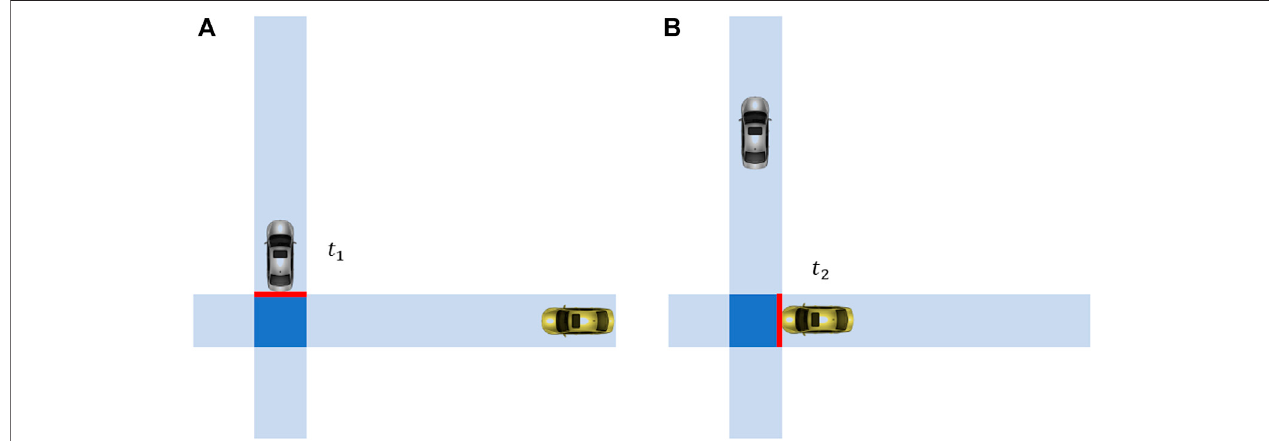
FIGURE 5 | De fi nition of post encroachment